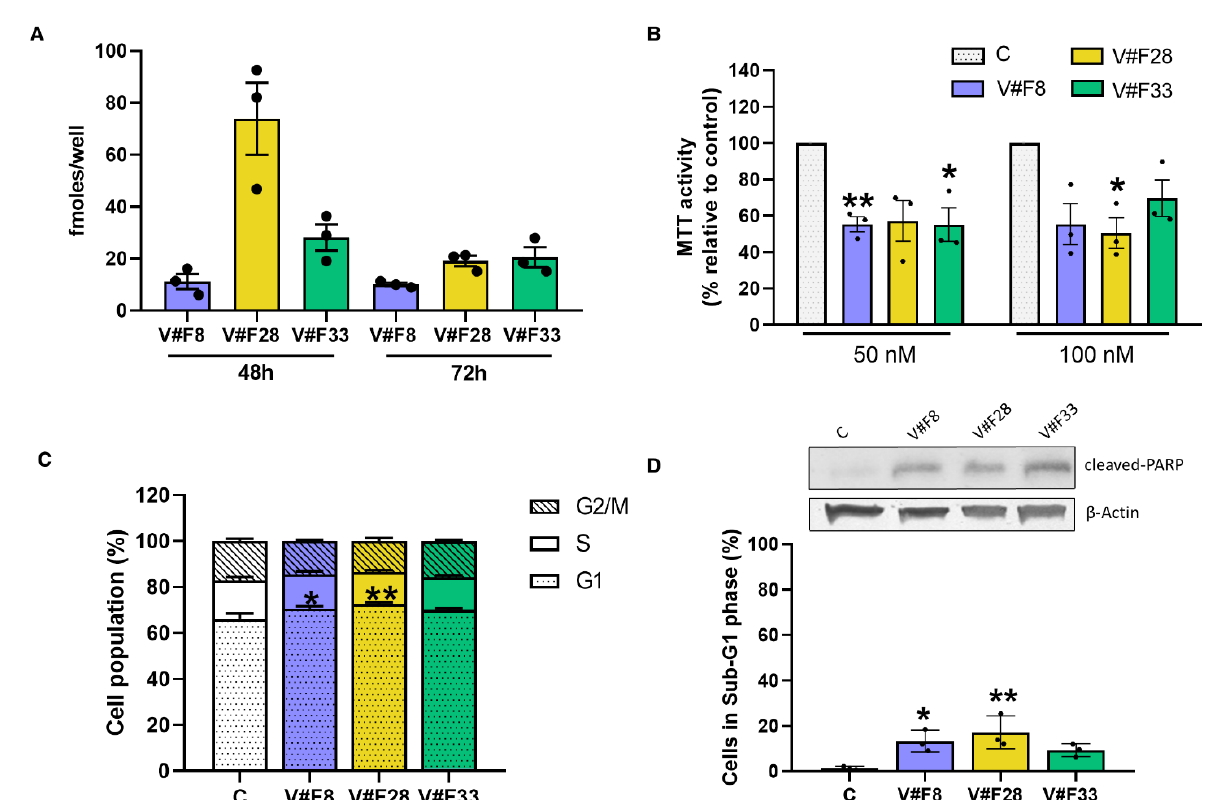
Figure 4. VRK1 aptamers decrease cell viability, arrest cells in G1 phase of cell cycle and increase apoptosis. ( A ) MCF7 cells were plated at 10 4 cells/well in p96 plates. After 24 h, aptamers were transfected at 50 nM for 48 and 72 h and intracellular accumulation of the aptamers was measured as described in the Materials and Methods Section. (B) MCF7 cells were plated at 10 4 cells/well in p96 plates. After 24 h, aptamers were transfected at 50 and 100 nM for 48 h, then MTT assays were performed. ( C , D ) MCF7 cells were transfected with 50 nM aptamers. After 72 h cells were stained with PI and subjected to flow cytometry analysis. The percentage of cells gated in each phase is indicated. ( D ) Top, Lysates were subjected to SDS-PAGE 12% and Western blot analysis was performed as described in the Materials and Methods Section. Actin was used as a control for the homogeneity of loading. A representative blot is shown. Cells transfected with no aptamer were used as the control. Bars represent the mean ± SEM of 3 independent experiments. Statistical differences relative to the control; * p < 0.05; ** p < 0.01.